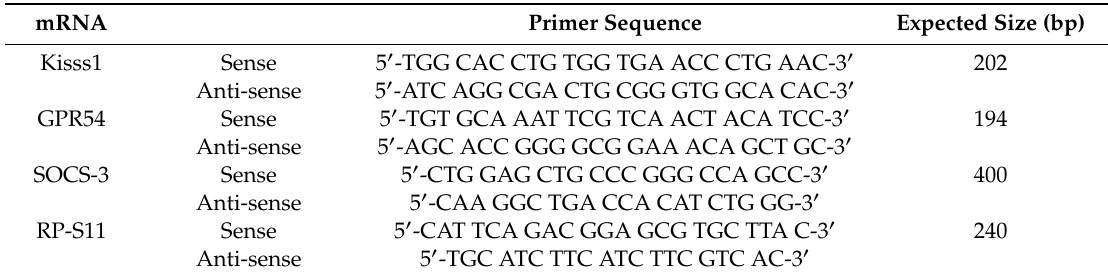
Table 6. The primer sequence and products size for